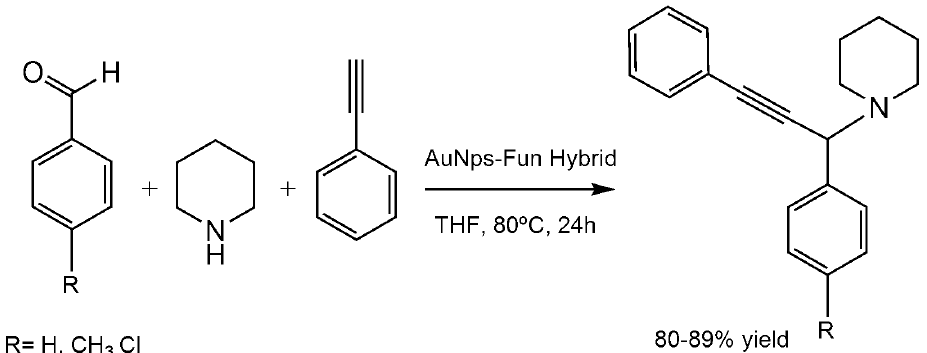
Figure 15. Multicomponent reaction catalyzed by AuNPs Hybrid.